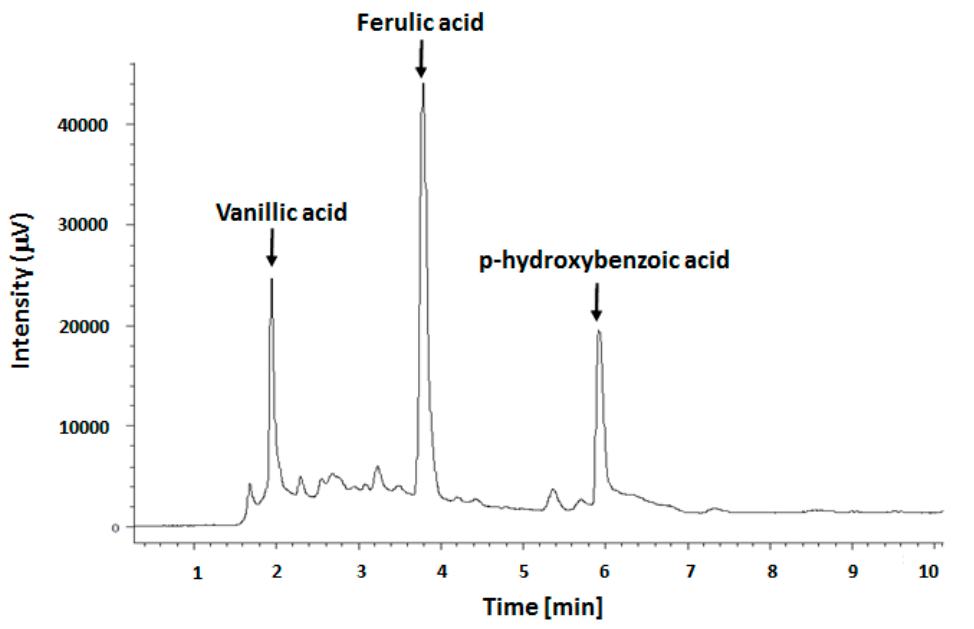
Figure 1. RP-HPLC separation of phenolic compounds for our phenolic extract from FS oil. Table 1. Total phenolic content (TPC), and amounts of three main phenols fractions were evaluated from flaxseed oil. Data are the mean value of three analytical replicates and three-independent samples plus/minus the standard deviation. In details, TPC is expressed both as mg of gallic acid equivalent/100 g of oil and as mg of caffeic acid equivalent/100 g, and the three phenols as µg/g Phenolic Extract Dry Weight (DW PE).